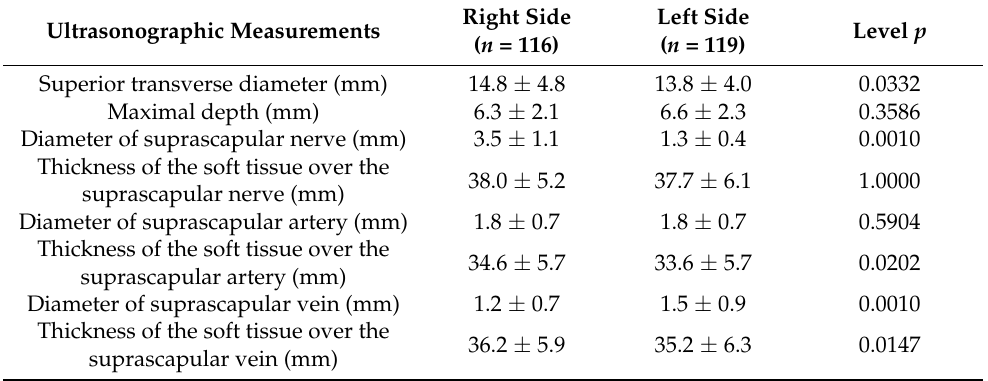
Table 4. Comparison of sonographic measurements between body sides. Differences that are significant according to Bonferroni’s correction are